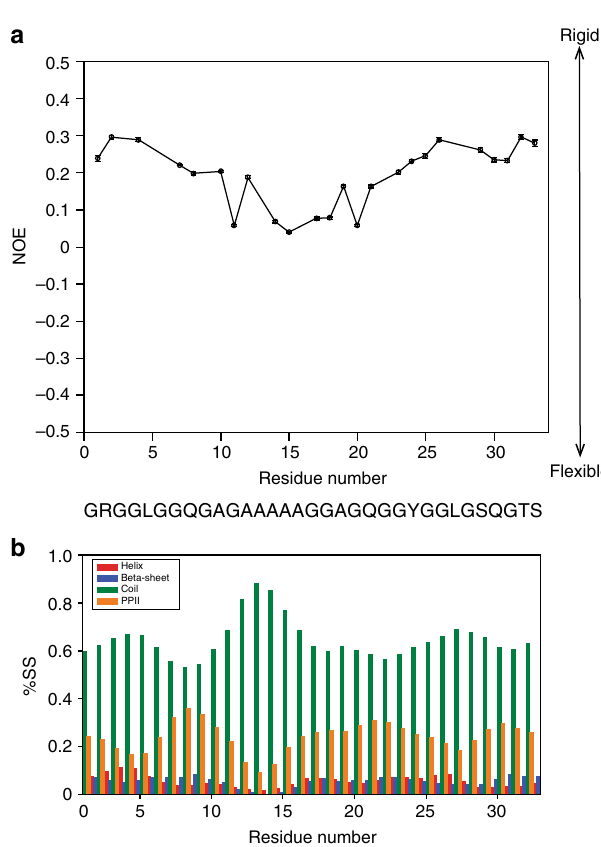
Fig. 3 Backbone dynamics and secondary structure population of repetitive domains. a { 1 H} – 15 N heteronuclear NOE of the 15-mer. b Secondary structure population of the 15-mer based on backbone chemical shifts. Overlapping peaks in { 1 H} – 15 N heteronuclear NOE spectra were not included in the { 1 H} – 15 N heteronuclear NOE graph of the 15-mer. %SS denotes % secondary structure. Error bars in { 1 H} – 15 N heteronuclear NOE graph was calculated based on base plane noise in the 1 H – 15 N HSQC spectra with and without proton saturation (equation